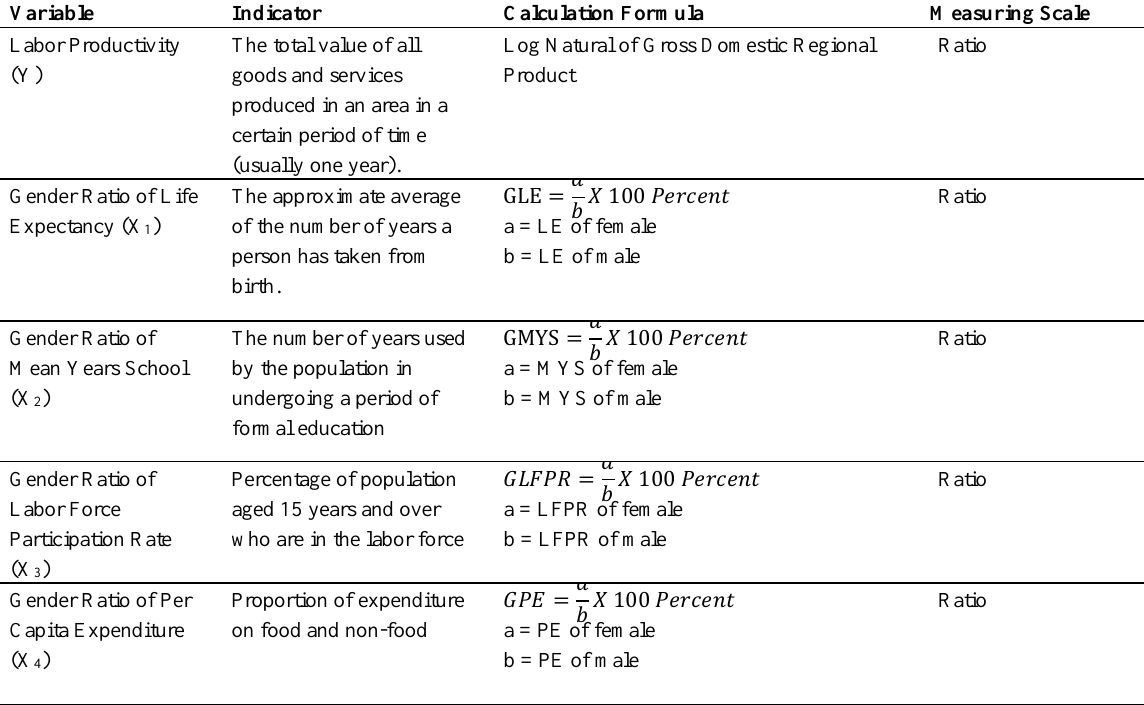
Table 1: Variable Measurement Calculation Formula Measuring